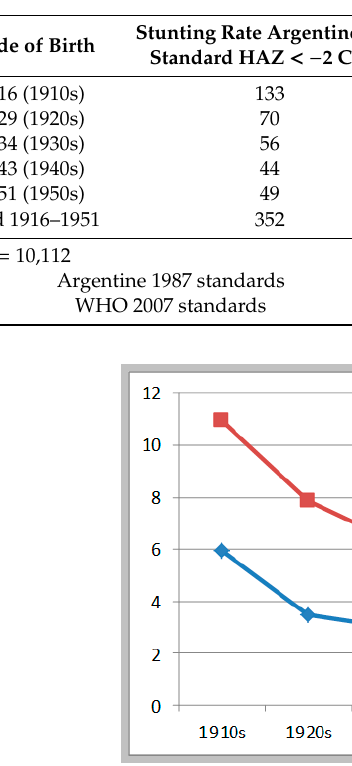
Table 6. Stunting rates by decade Recruits from Pampa Region b.1916–1951.